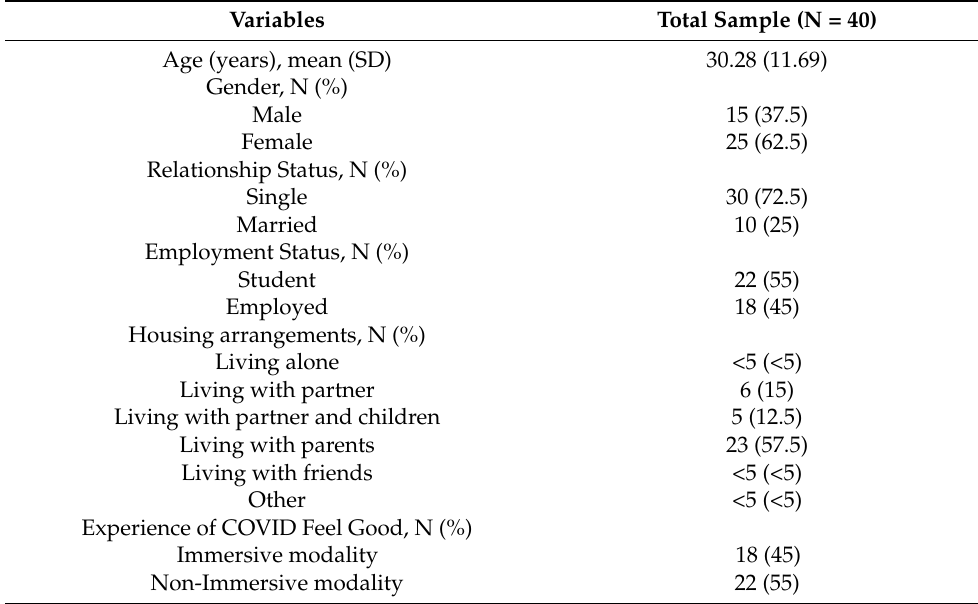
Table 1. Demographic characteristics of